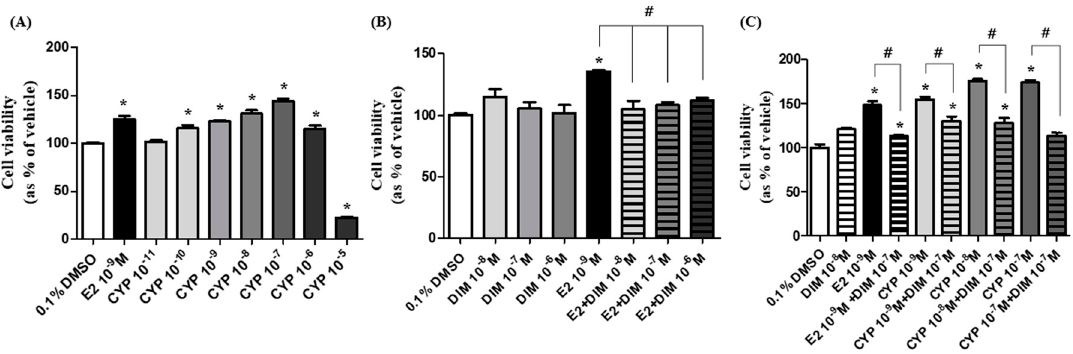
Figure 1. Effects of Cyprodinil (CYP) exposure on cell viability of Ishikawa endometrial cancer cells. Ishikawa cancer cells were treated with 0.1% DMSO as a control, E2 (10 − 9 M), CYP (10 − 11 –10 − 5 M), or 3,3 ′ -Diindolylmethane (DIM) (10 − 8 –10 − 6 M) for six days, after which the cell viability was measured by MTT assay. The experiment was repeated three times, and data were reported as the means ± SD. ( A ) Effects of E2 and CYP on cell viability. * indicates a significant difference in cell viability by E2 or CYP compared to the control ( p < 0.05 according to Dunnett’s multiple comparison test); ( B ) Effects of the mixture of E2 and DIM on cell viability. * shows a significant difference in cell viability by E2 or DIM compared to the control ( p < 0.05 according to Dunnett’s multiple comparison test). # shows a significant reduction in cell viability in response to E2 + DIM compared to E2 alone ( p < 0.05 according to Dunnett’s multiple comparison test); ( C ) Effects of the mixture of CYP and DIM. * shows a significant difference in cell viability in response to E2, DIM, CYP, E2 + DIM, or CYP + DIM compared to the control ( p < 0.05 according to Dunnett’s multiple comparison test). # shows a significant reduction in cell viability in response to E2 + DIM compared to E2 alone or CYP + DIM compared to CYP alone ( p < 0.05 according to Dunnett’s multiple comparison test).